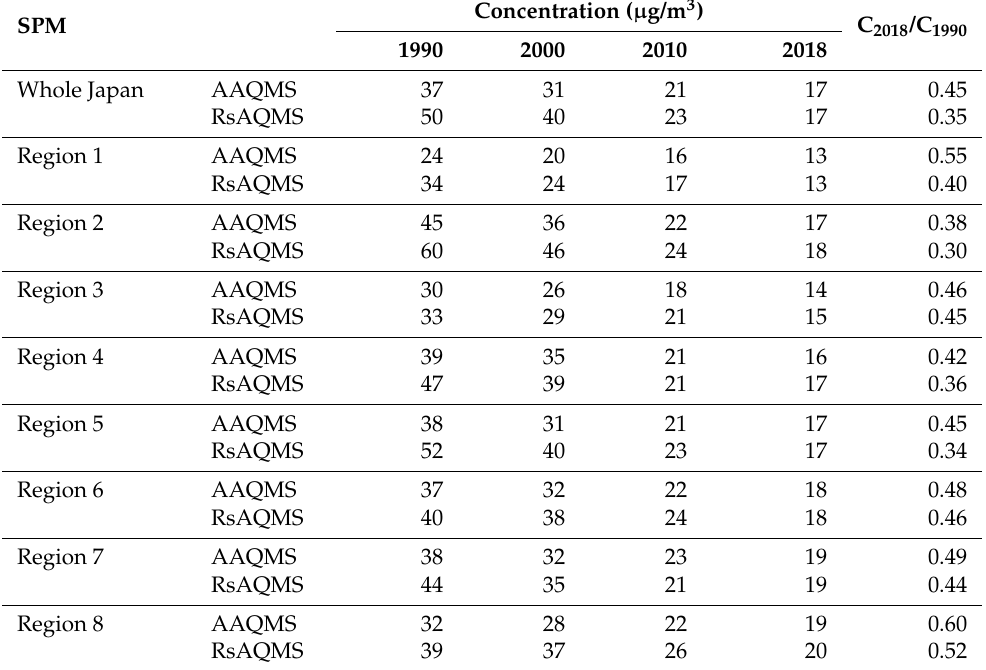
Table 4. Annual average concentration of SPM at the AAQMS and RsAQMS of the nation and each region in 1990, 2000, 2010 and 2018, and the ratio of concentrations in 2018 to 1990.